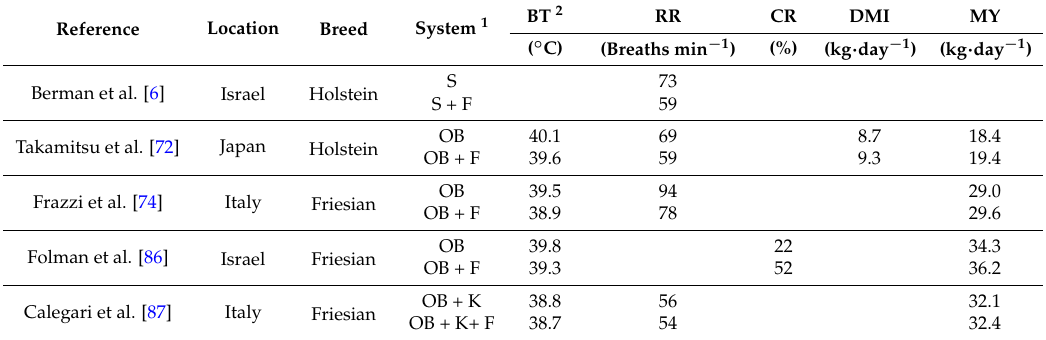
Table 8. Physiological response of dairy cows for control treatments and barns equipped with high-speed fans.